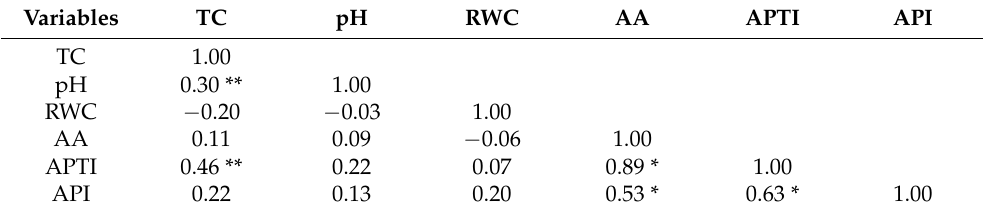
Table 6. Pearson correlation matrix for the calculated